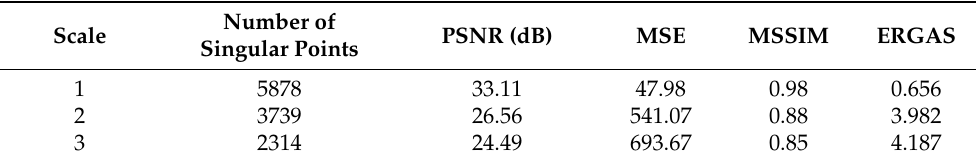
Table 4. Average number of interest points of the reconstructed images at different scales and their corresponding image PSNR, MSE, MSSIM, and ERGAS values.